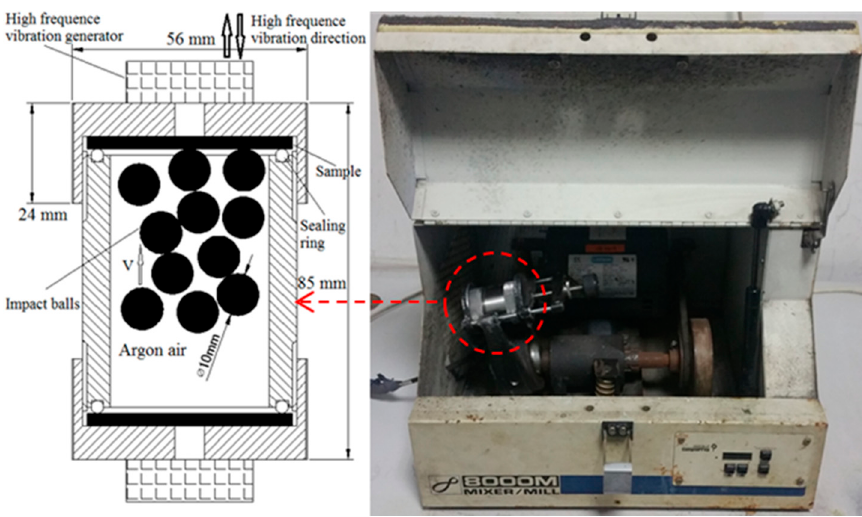
Figure 9. A schematic view of the Spex mill.